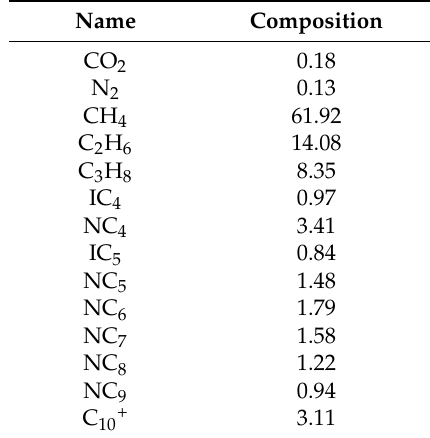
Figure 7. The liquid dropout curve of reservoir fluid at 93.3 °C (200 °F). Table 3. Reservoir fluid composition.